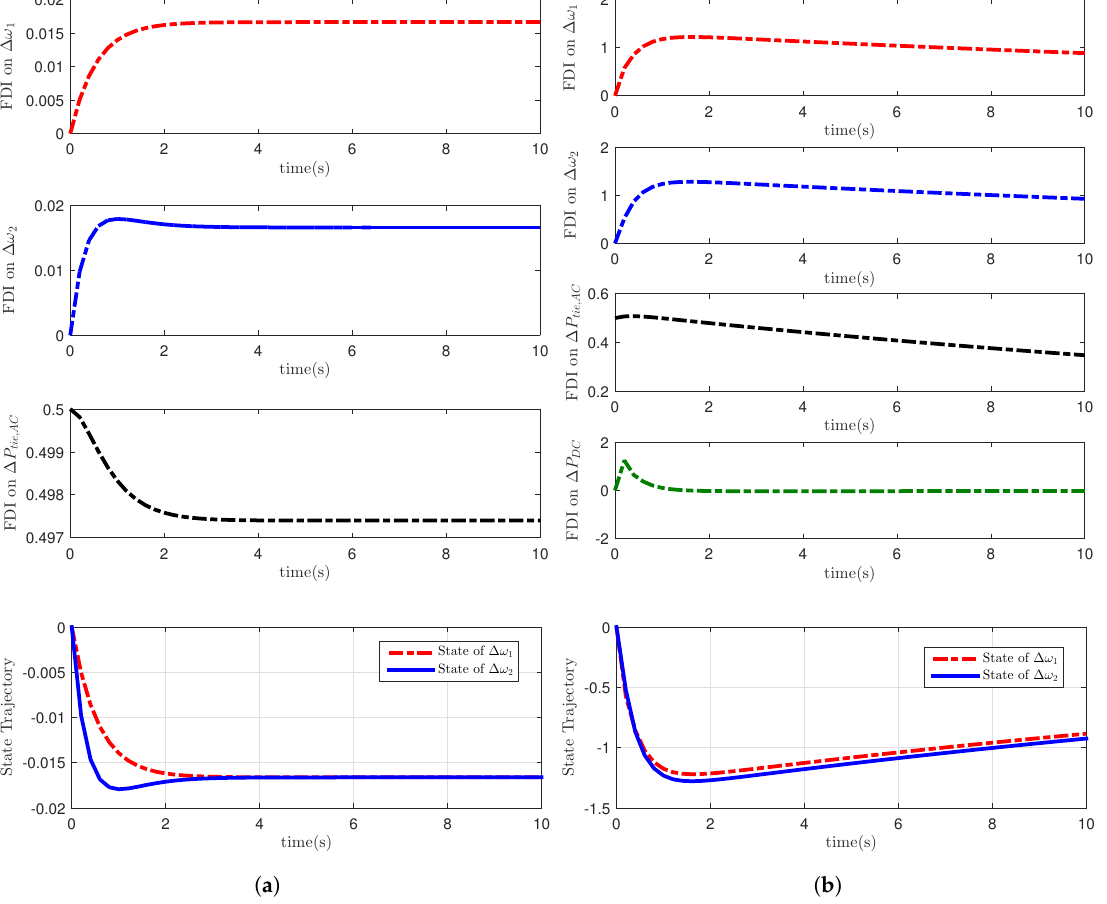
Figure 9. State trajectory under zero-dynamics attacks on wide-area measurements with f being the injection on the AC power flow measurement with a value of 0.5p.u.. ( a ) normal AC system; ( b ) AC/DC system with virtual